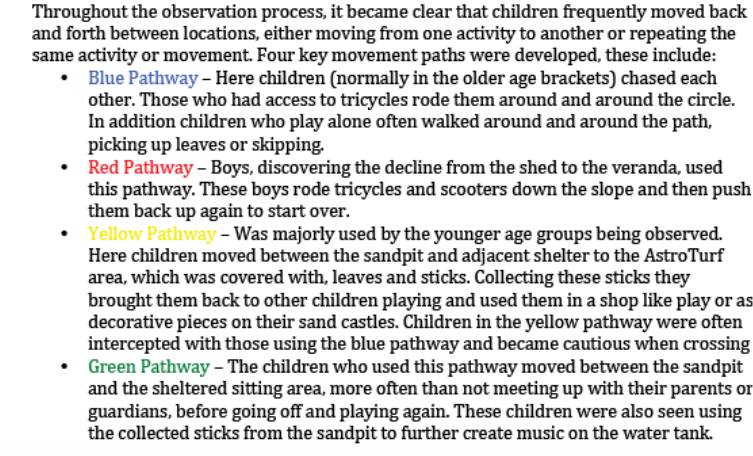
Figure 2. Excerpt from student observation